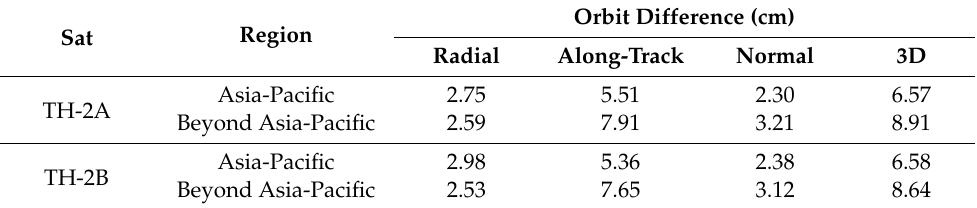
Table 4. Average RMS of orbit differences between BDS2- and GPS-based POD in different regions.